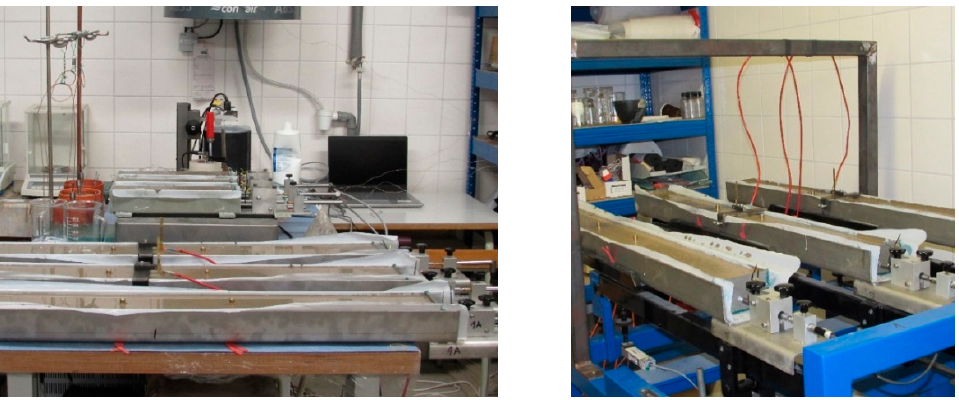
Figure 3. Overall view before start of measurement.